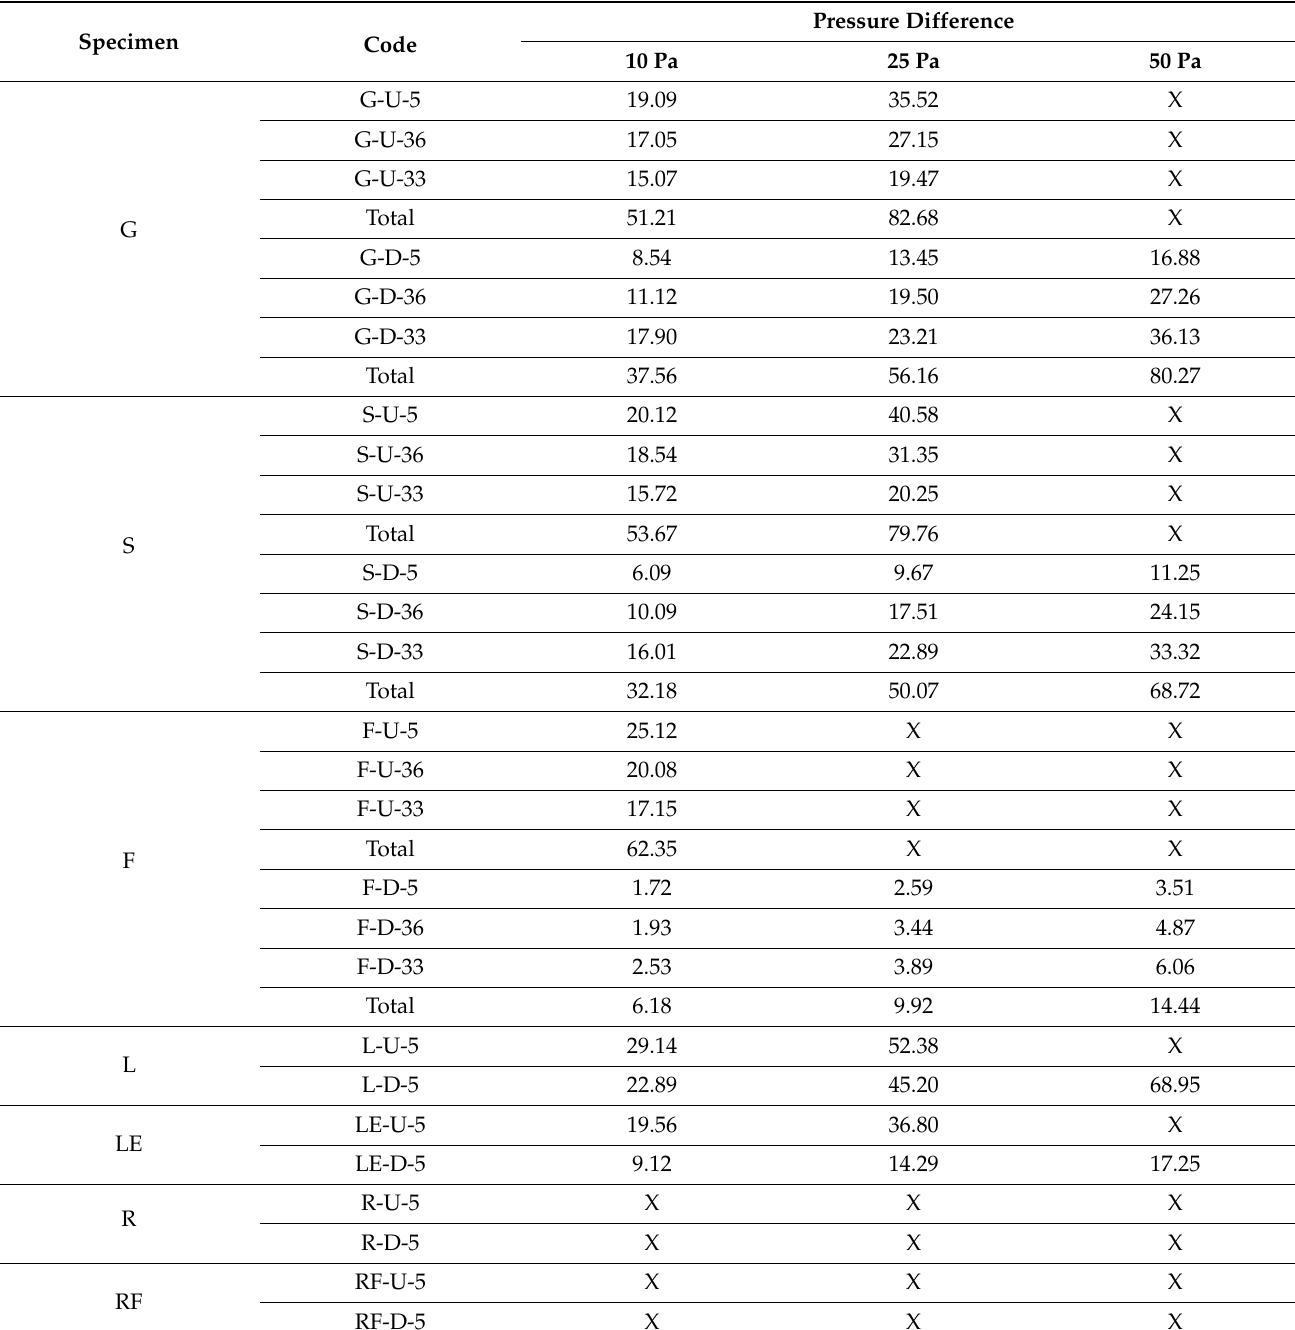
Table 1. Average leakage volume (m 3 /h) of each specimen at each pressure difference and with different smoke flow